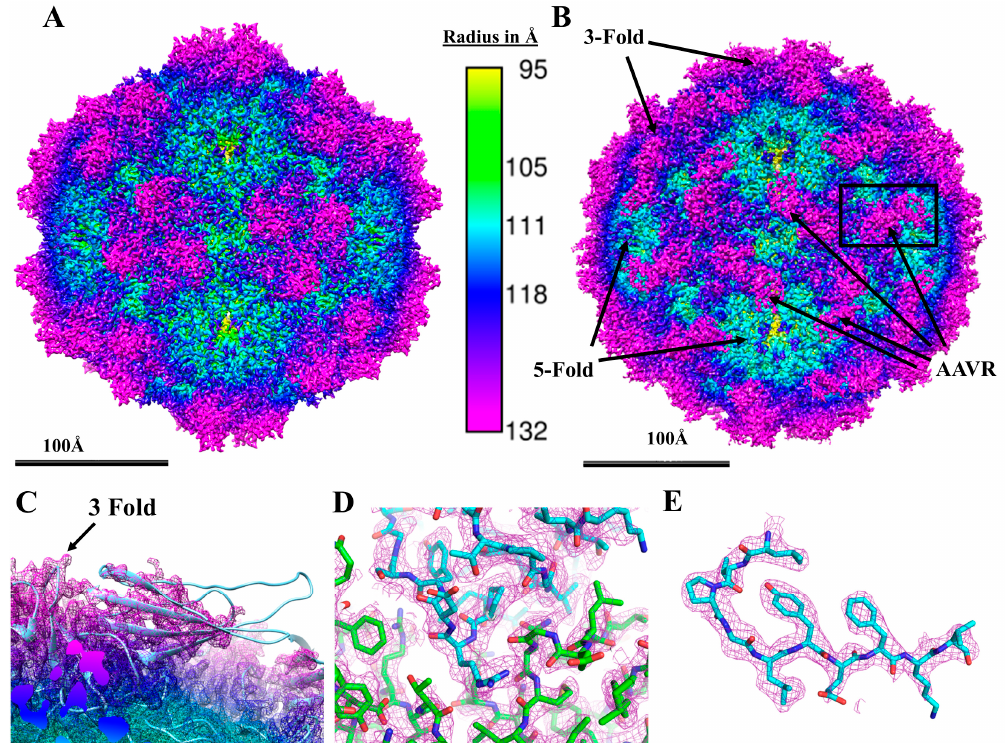
Figure 1. Cryo-EM reconstructions of AAV5 ( A ) and its complex with receptor AAVR ( B – D ). ( A ) The cryo-EM Coulombic potential map for native AAV5 at 2.1Å contoured at 1.6 sigma, colored by distance from the center of the map. ( B ) The complex of AAV5-PKD1-2 similarly rendered. The C-terminal half of the PKD1 is visible bound to each three-fold spike pointing toward the five-fold axis. ( C ) A magnified image of the outlined region in panel ( B ) with the PKD1 model built into the electron density. The Coulombic potential is strong where PKD1 is more tightly interacting with the three-fold proximal virus spike, but for the third of the domain close to the five-fold axis (right side) the map is much weaker due to presumptive disorder. ( D ) The binding site of AAV5-PKD1 shows PKD1 (blue carbon atoms) interacting with AAV5 (green carbon atoms). The coulombic potential map is shown contoured at 2.4 sigma as a violet mesh. ( E ) Detail of the PKD1 domain, showing recognizable features of the distinctive sequence 372 LTPGLYEFKV 381 running anti-clockwise from the top.